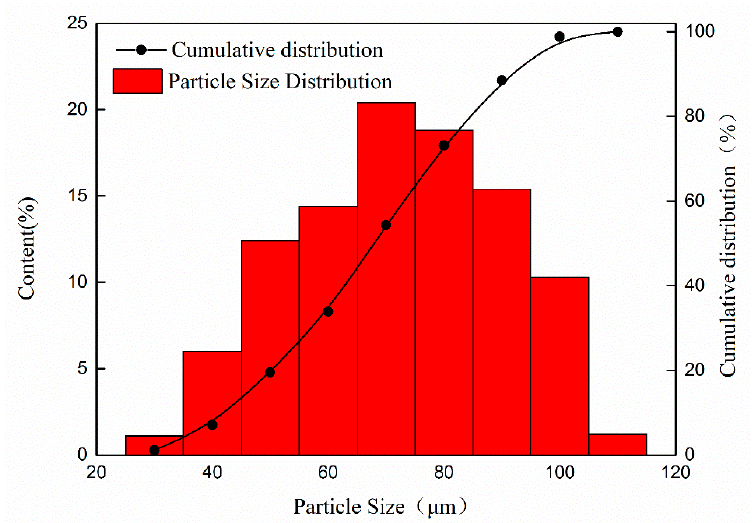
Figure 2. Particle size distribution of the micron-sized-particle-dense medium.